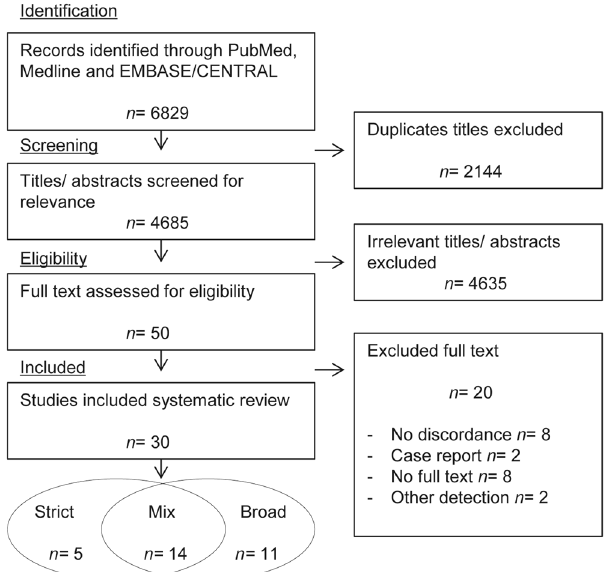
Figure 1. Flow chart of eligible studies for meta-analysis. Strict definition of HER2 assessment: HER2 positivity defined as IHC score 3 + or IHC score 2 + with an amplification of the HER2/neu gene by in situ hybridization (ISH). Broad definition: include IHC scores 2 + and 3 + marked HER2 positive (irrespective of ISH) or amplification of the HER2/neu gene without additional IHC analysis. Mix: Include data of both strict and broad definitions of HER2 status determination; articles used in pair-wise